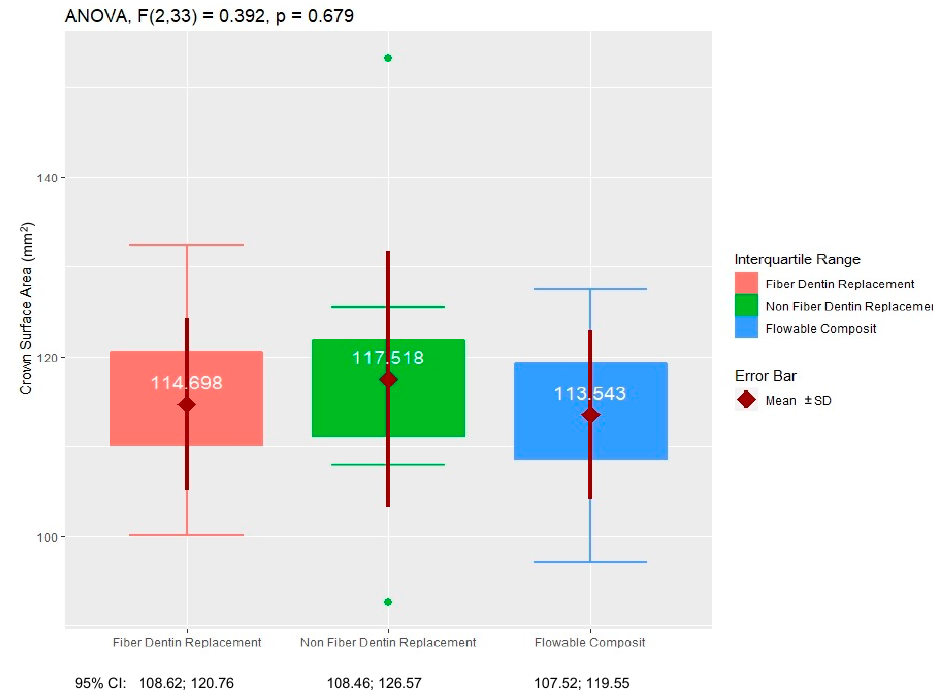
Figure 2. Sample distribution based on the crown surface area.